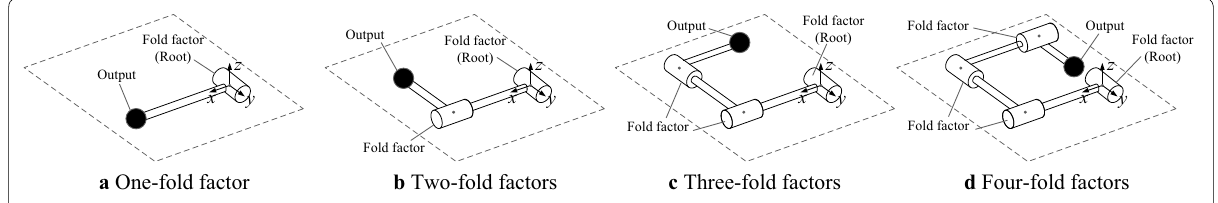
Figure 8 DKC configurations with different numbers of fold factors